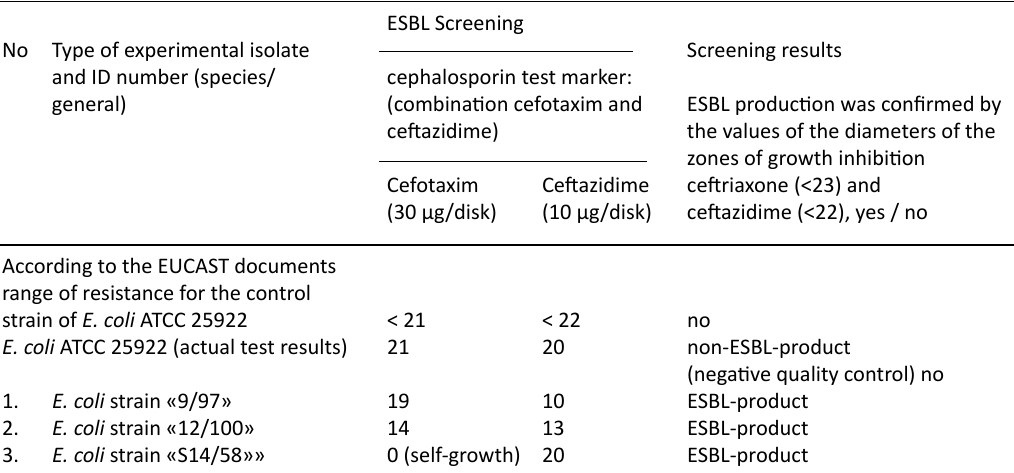
Table 2. Screening for ceftazidime-resistant E. coli isolates for confirmation of ESBL-producers ESBL Screening